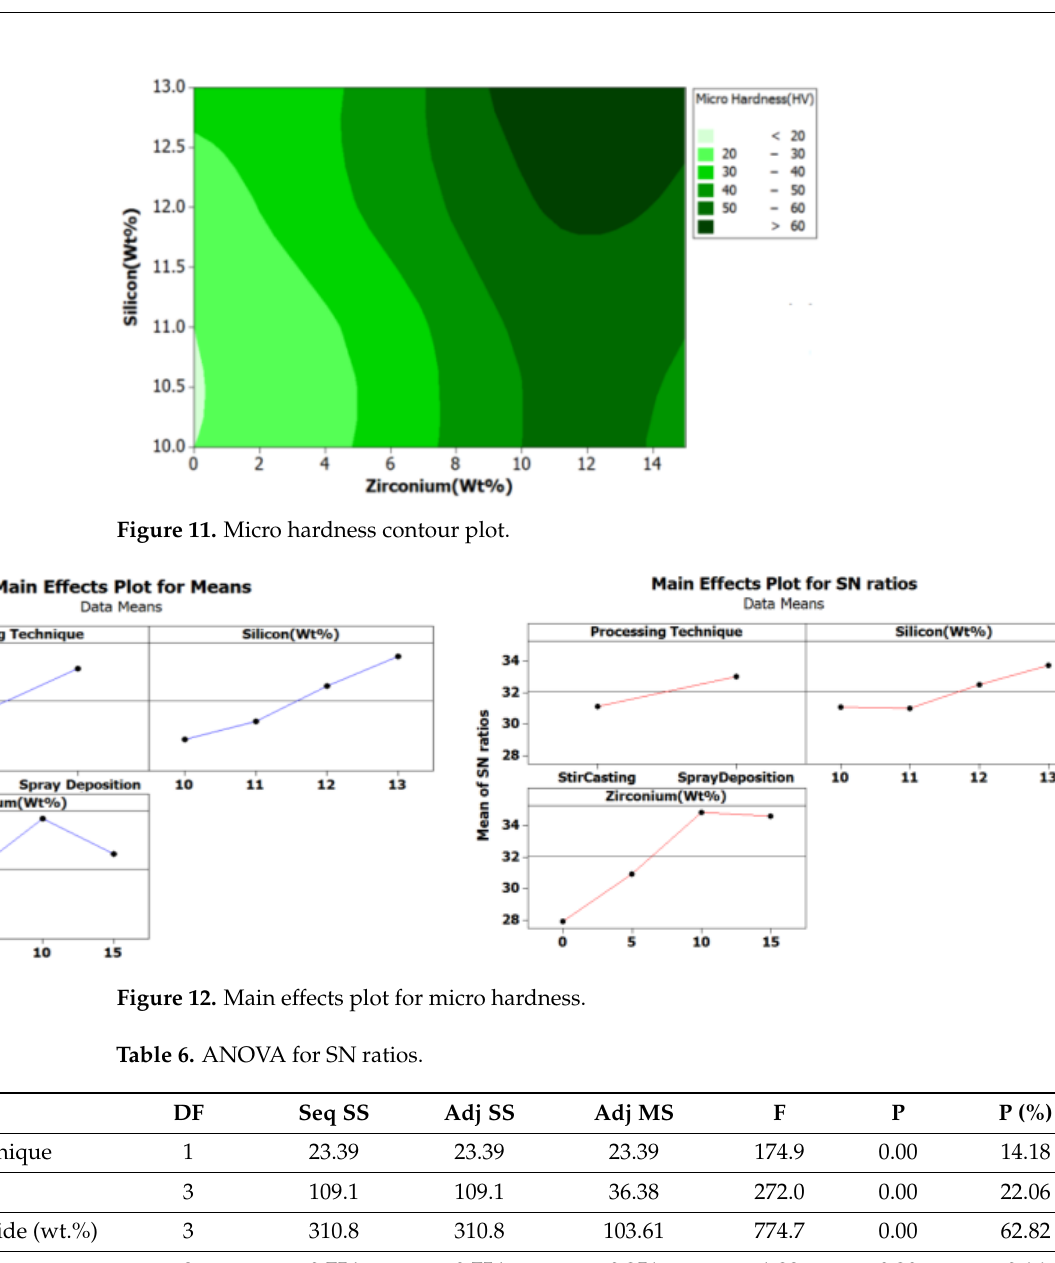
Table 6. ANOVA for SN ratios.